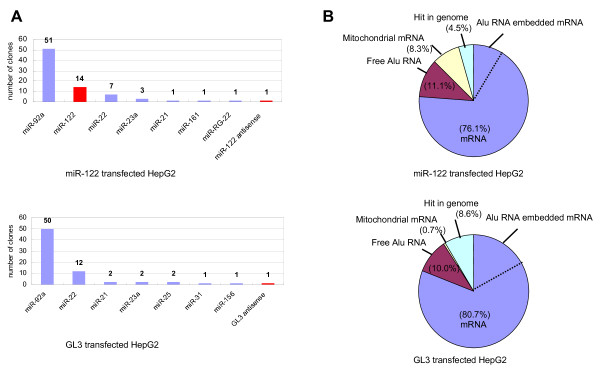
Contents of miRNA and mRNA cDNA clones obtained from immunoprecipitates of miR-122- and GL3-transfected HepG2 cells. A: Contents of miRNA clones. 89 clones were analyzed for the miR-122-transfectant and 84 for the GL3-transfectant. Red bars show recovered miRNA clones originating from transfected nucleotides (upper figure; miR-122-transfected HepG2 cells, lower figure GL3-transfected HepG2 cells). B: Composition of RISC-associated polyA-containing RNA. The isolated cDNA clones were analyzed by BLAST search and classified into categories. The composition of each categorized RNA is shown (Upper figure: miR-122-transfected HepG2 cells, lower figure: GL3-transfected HepG2 cells). Alu RNA embedded mRNA is included in mRNA area. The percentages of Alu RNA embedded mRNA in the miR-122 and the GL3 transfectants were 10% and 19%, respectively.